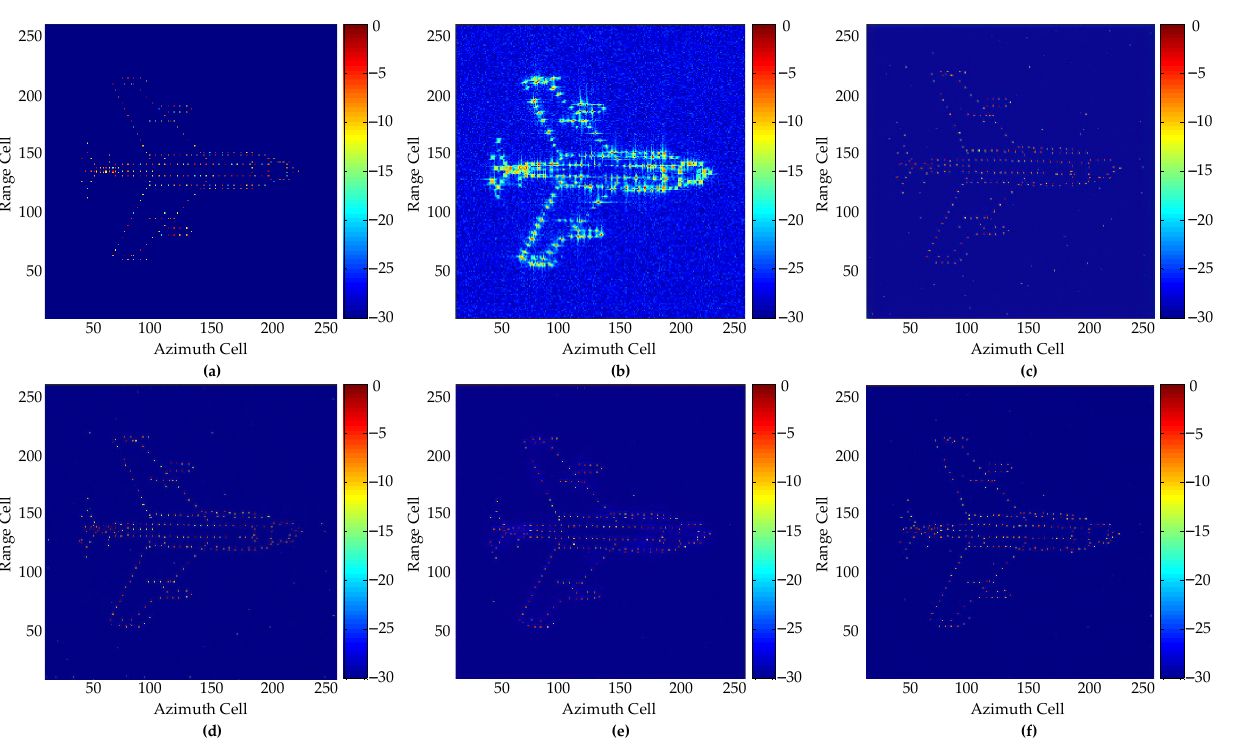
Figure 8. Imaging results of simulated aircraft at SNR = − 4 dB: ( a ) Ground truth; ( b ) IFFT; ( c ) GAN1; ( d ) GAN2; ( e ) GAN3; ( f ) Proposed GAN. Table 3. Numerical performance evaluation for simulated aircraft at SNR = 2 dB.